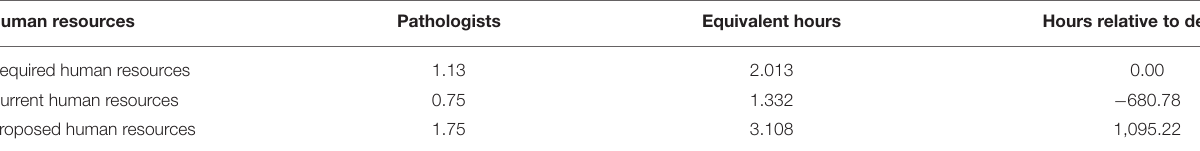
TABLE 6 | Number of pathologists required to meet current demand. Human